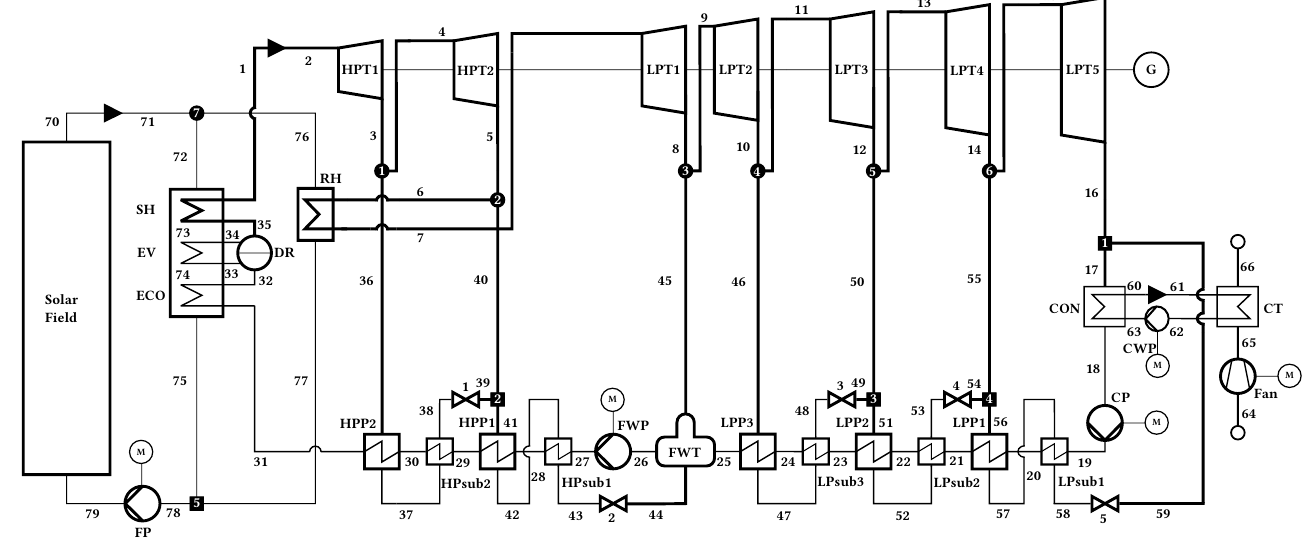
Figure 5. Flow chart of SEGS implemented in